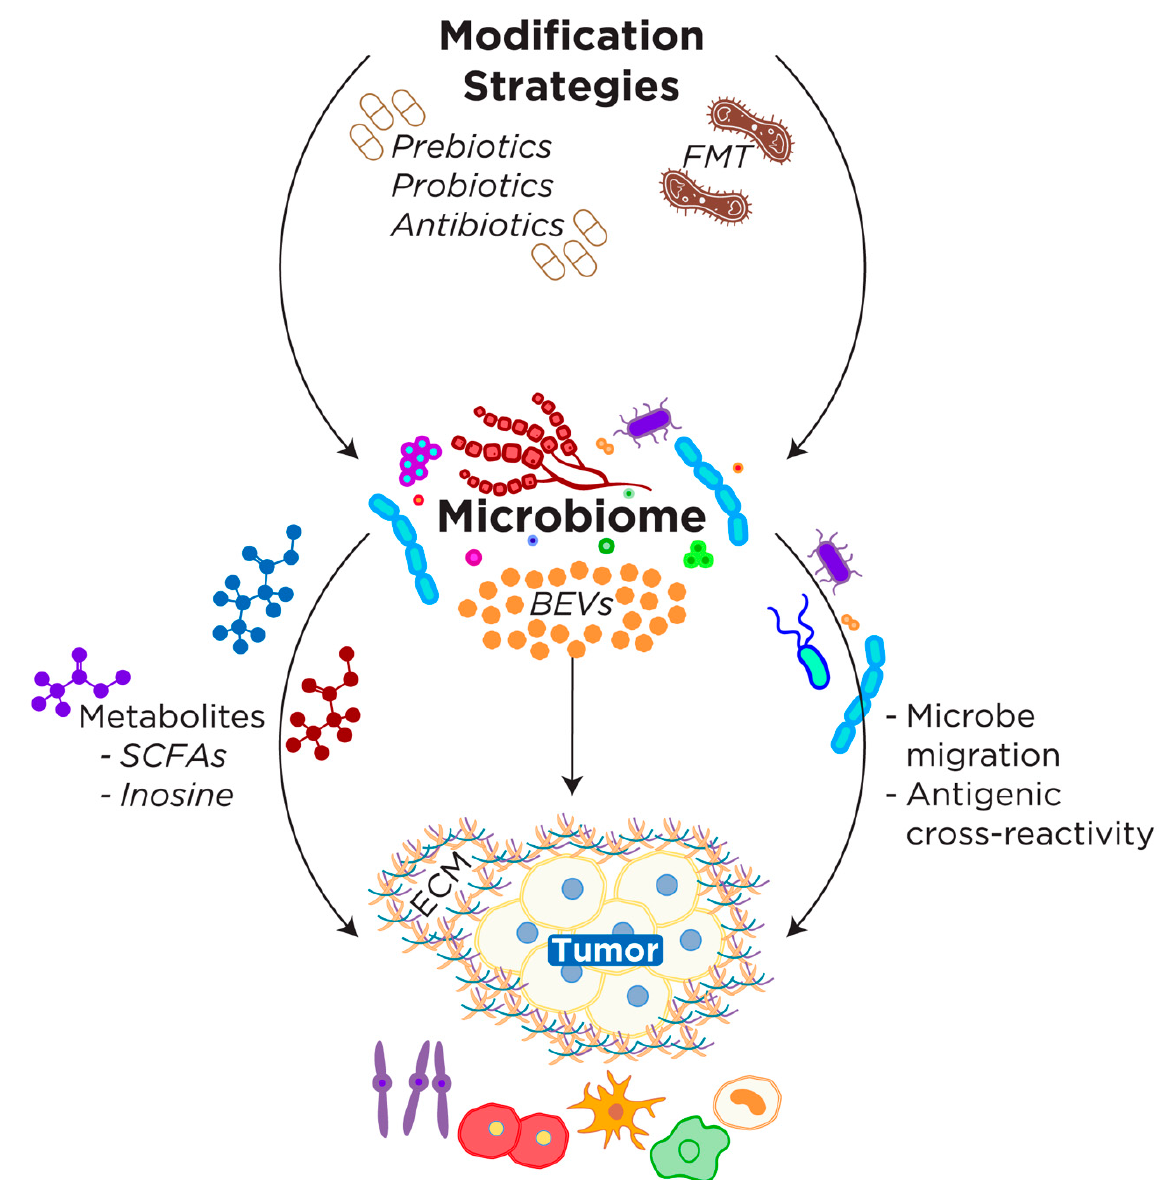
Figure 2. The Microbiome-TIME axis and associated modification strategies. The microbiome-TIME axis refers to the effect that microbiota have on the TIME through one or a combination of the following possible mechanisms including local (and possibly remote) microbe migration, antigenic cross-reactivity, metabolites and bacterial extracellular vesicles (BEVs). Microbes can directly migrate to and colonize the TIME, or they can produce metabolites, such as short chain fatty acids (SCFAs) that enter circulation to alter the TIME. Many modification strategies have been proposed to alter the patient’s microbiome and, thus, alter the TIME. These methods are discussed in greater detail below but include FMT, antibiotics and pre/probiotics. Table 1. A summary of the role of microbiota on the development and progression of cancer.